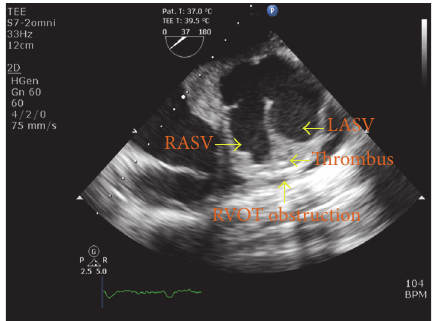
Figure 3: Transesophageal echocardiography ∗ revealed left aneurysm of sinus of Valsalva (LASV) and right aneurysm of sinus of Valsalva (RASV) with thrombus within it, causing RVOT obstruction. ∗ Aortic valve short-axis view at midesophageal level.